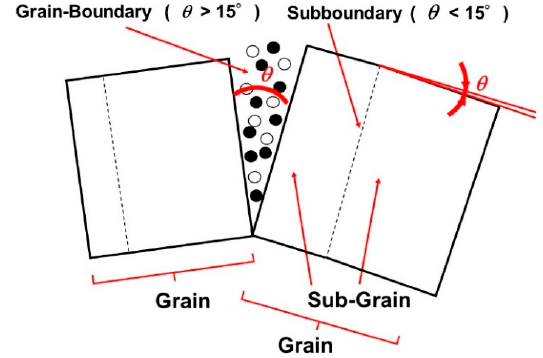
Figure 5. Definition of grain boundary and sub-boundary.